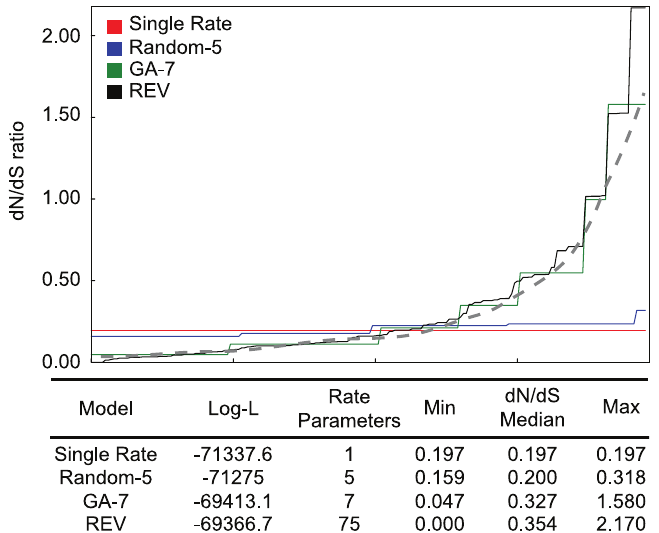
Figure 2. Evolutionary rate estimation as ‘‘curve fitting.’’ An example from HIV-1 polymerase gene alignment for which the GA inferred 7 non-synonymous rate classes. The idealized biological rate distribution (unobservable) is depicted by the dashed line. The goodness of fit, the complexity of the models, and the range of maximum likelihood parameter estimates are listed in the table.